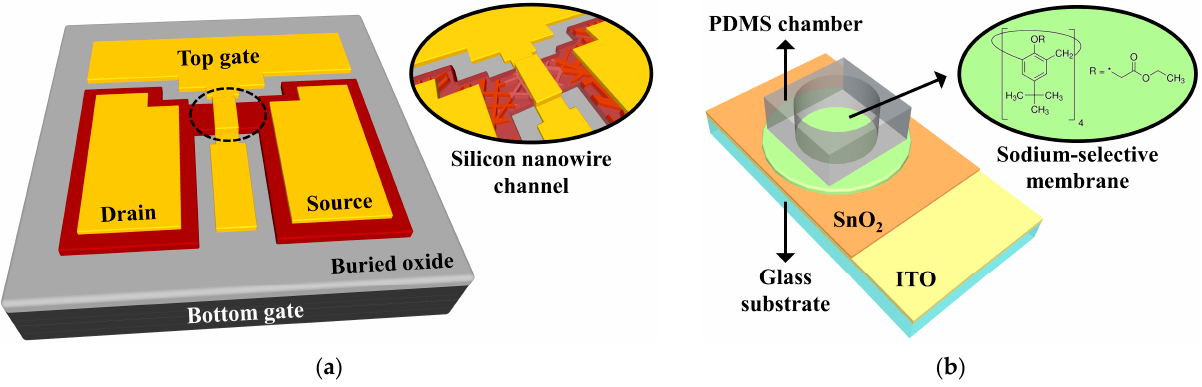
Figure 3. Schematic of the ( a ) SiNW channel DG FET transducer unit and the ( b ) sodium-selective membrane EG sensing unit.